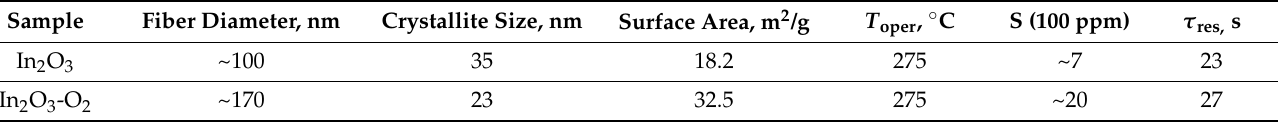
Table 8. Influence of oxygen plasma treatment on the parameters of In 2 O 3 fibers, and conductometric response to acetone. Sample Fiber Diameter, nm Crystallite Size, nm Surface Area, m 2 /g T oper , ◦ C S (100 ppm) τ res, s In 2 O 3 ~100 35 18.2 275 ~7 23 In 2 O 3 -O 2 ~170 23 32.5 275 ~20 27 Source : data extracted from